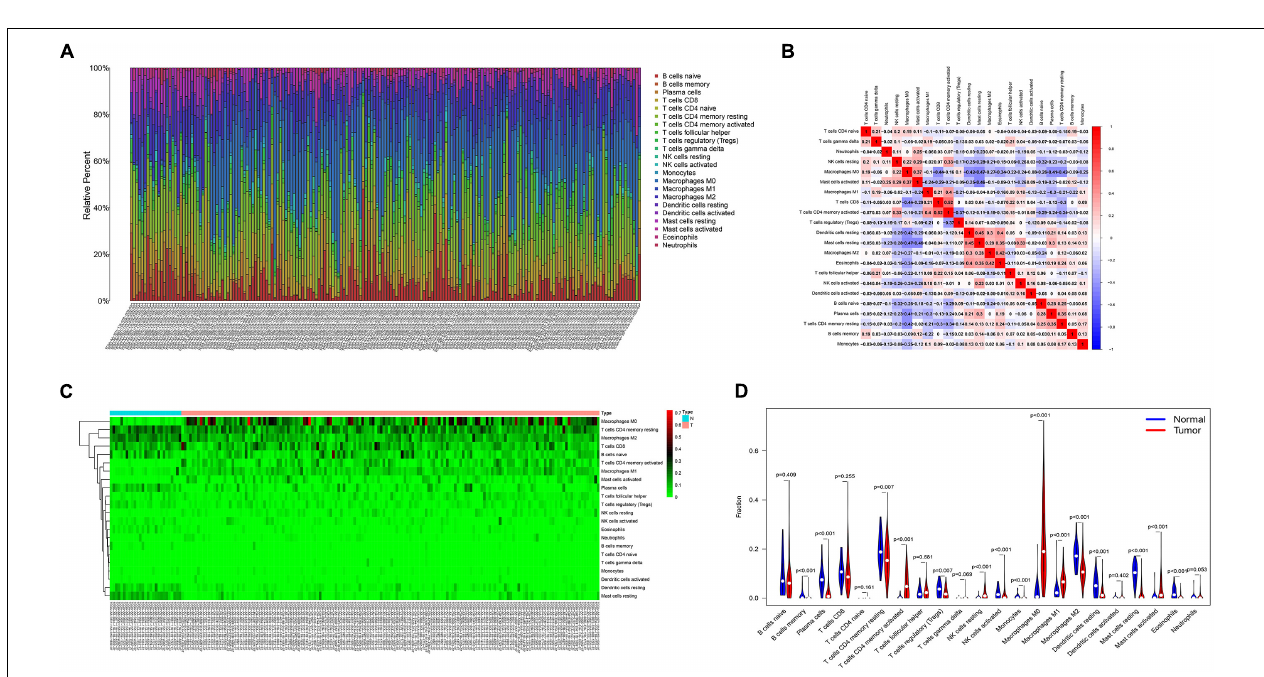
FIGURE 3 | (A) Lasso regression analysis to screen prognostic-related genes. (B) Calculating the risk score of each patient and establishing the risk model. (C) Cox regression analysis of seven RNAs. (D) Comparison of prognostic differences between the high- and low-risk groups divided by the model. (E) Evaluation efficacy of the risk model at 1, 3, and 5 years. (F) Visual display of the nomogram patient prognosis evaluation model. (G) A 3-year evaluation efficacy of the nomogram model.